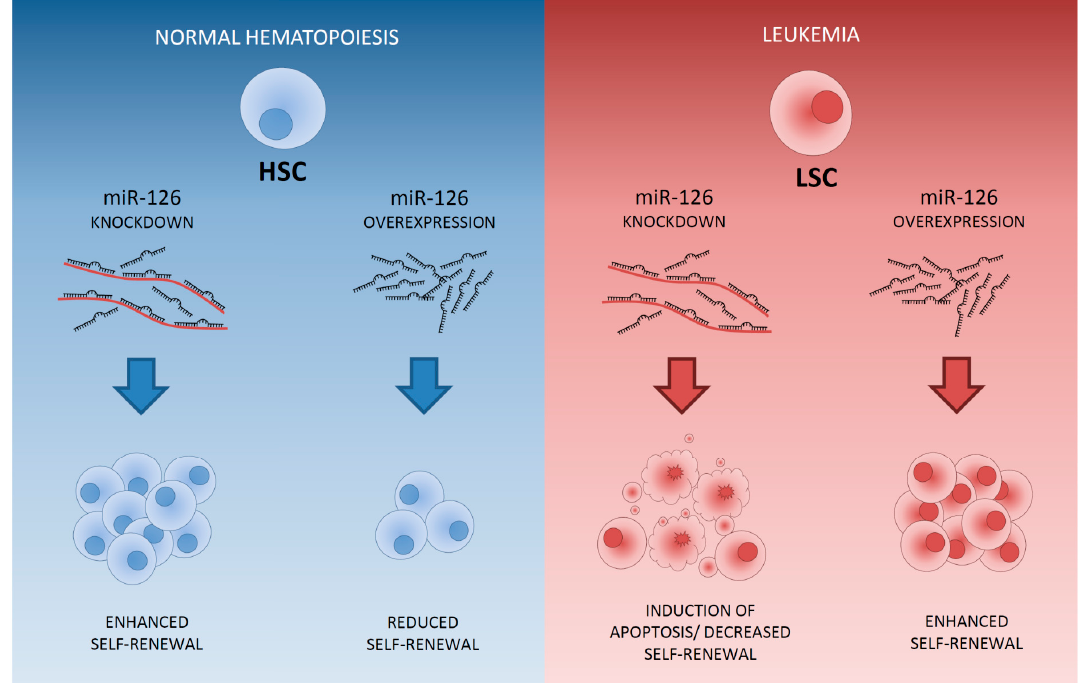
Figure 4. MiR-126 expression and modulation in normal hematopoiesis and leukemia. MiR-126 is highly expressed in normal HSCs. A reduction in miR-126 expression in HSCs, for example by lentiviral sponges, increases AKT signaling thereby inducing cell-cycle entry via CDK3 that leads to enhanced self-renewal and expansion of long-term HSCs. Overexpression of miR-126 in HSCs, by mimics or internal and external stimuli (cytokines), results in a reduction in AKT signaling impairing cell-cycle entry resulting in increased quiescence and a gradual loss of hematopoietic output. In leukemia, LSCs highly express miR-126 as compared to leukemic progenitors. Knockdown of miR- 126 in LSCs increases AKT signaling, de-repressing CKD3, thereby inducing differentiation and proliferation leading to chemo-sensitivity and apoptosis. Overexpression of miR-126 in LSCs lowers AKT signaling and inhibits cell cycle entry leading to increased quiescence and self-renewal via the suppression of CDK3 resulting in chemotherapy resistance.